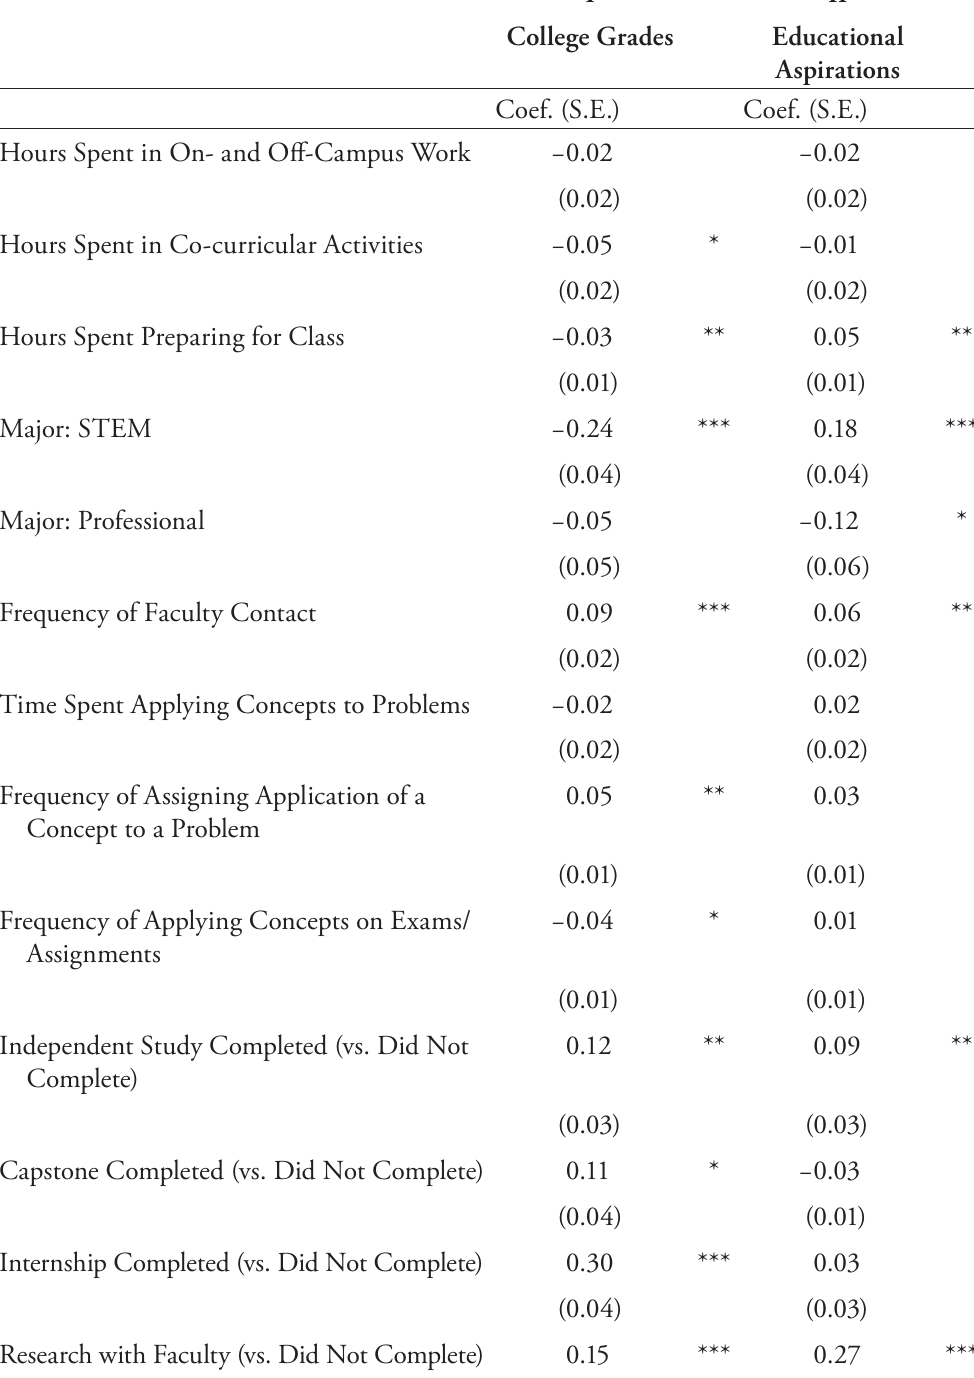
Table 3. Regression Estimates for the Association Between Applied Learning and Students’ Fourth- Year Grades and Fourth- Year Educational Aspirations (n = 4,028) ( continued